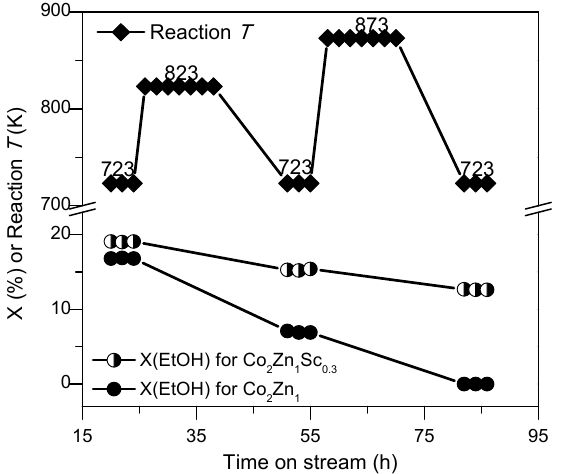
Figure 3. Thermal resistance of the catalysts Co 2 Zn 1 Sc 0.3 and Co 2 Zn 1 for ESR as a function of time on stream at different temperatures. Reaction conditions: 0.5 MPa pressure, 723–873 K temperature, 150,000 mL·h − 1 ·g -cat − 1 GHSV.